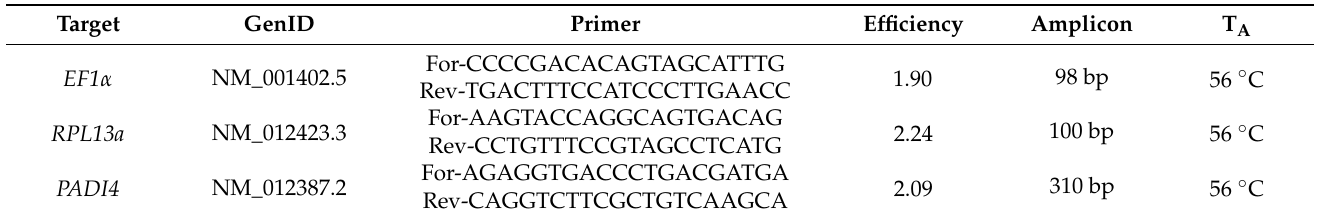
Table 2. Detailed information on primers (designed with primer blast) and the corresponding qPCR conditions. Primers were synthesized by Eurofins Genomics (Ebersberg, Germany).